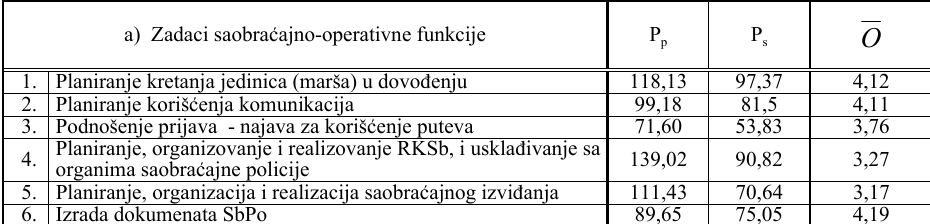
Prose~ne ocene zadataka SbPo u pripremi